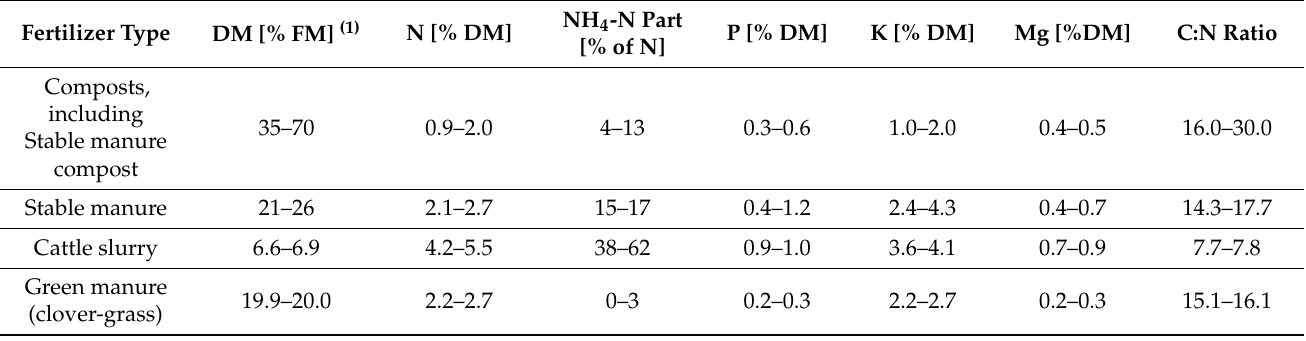
Table 2. Average nutrient contents of the organic fertilizers used.